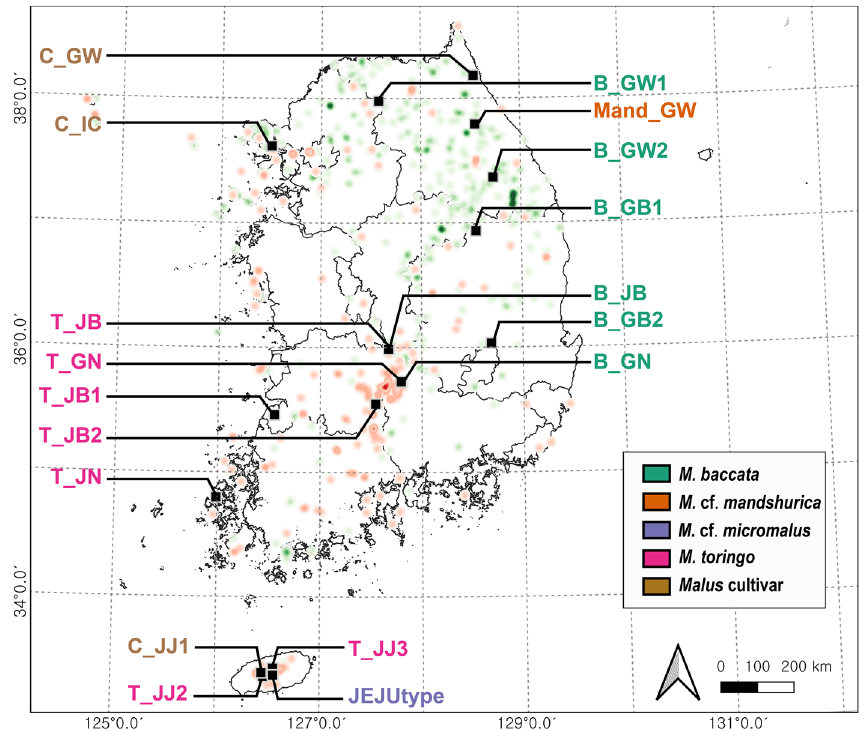
Figure 1. Heat map of 833 specimens deposited in both the Korea National Arboretum Herbarium (KH) and the National Institute of Biological Resources Herbarium (KB) were visualized using Qgis v3.26.1. Red color indicates M. toringo and green represents M. baccata . The black square indicates the sampling sites information for this study. Map source: https:// www. gisde velop er. co.